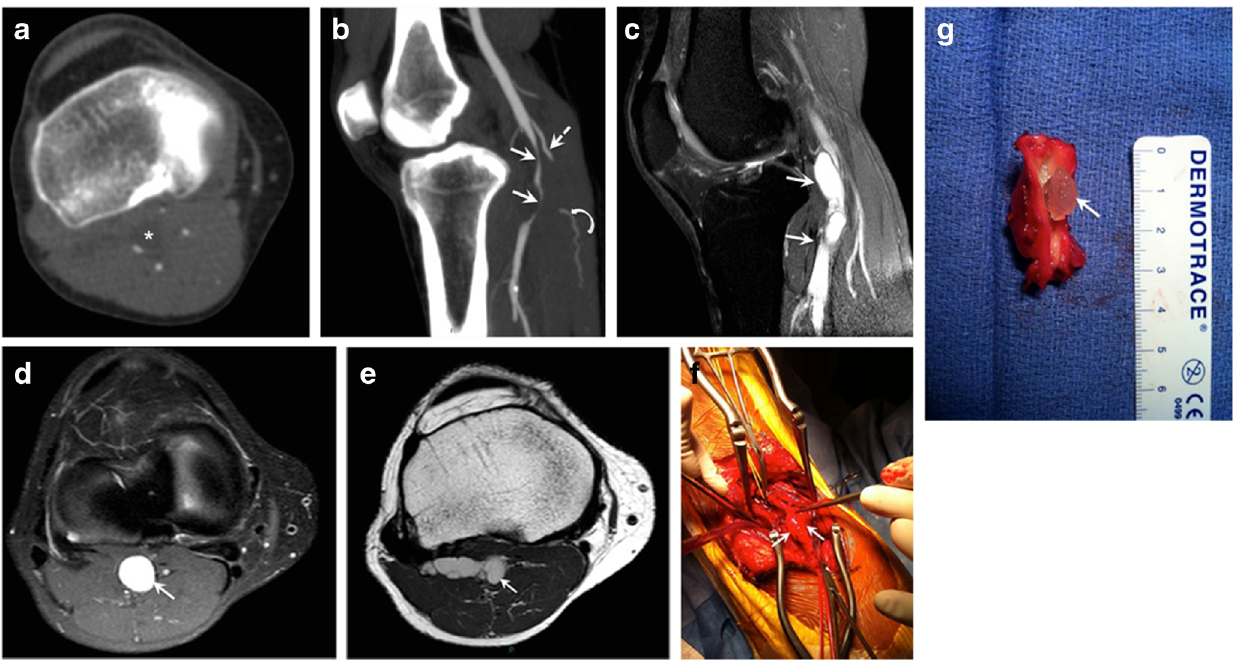
arrow ). ( c , d ) Sagittal and axial fat-suppressed T2-weighted MR images show hyperintense signal of the arterial wall mass ( arrows ) confirming its cystic nature. ( e ) Axial T1-weighted MR image shows hyperintense signal of the cystic mass ( arrow ) related to mucinous content. ( f ) Intraoperative photo showing cystic lesion arising from the popliteal artery wall ( arrows ). ( g ) Photograph of the resected specimen after longitudinal transection, showing cystic lesion developing within the lumen of the popliteal artery